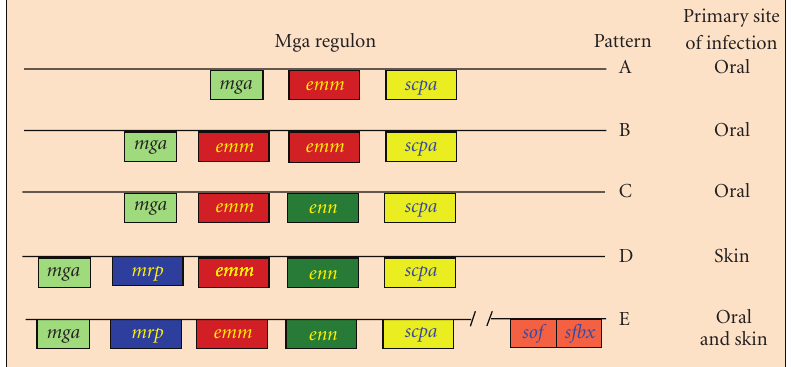
Figure 8: Variants of the Mga regulon and their relationship to preferential colonization of host sites. Mga (multigene activator) is a positive regulator of a number of streptococcal genes. The most prominent of these are the family of M proteins whose genes are tandemly linked. sof and sfbx are bicistronic and are also regulated by Mga, but are located some distance away. emm encodes for M protein, mrp encodes M-related proteins, enn encodes an M-like protein that binds IgA, and scpa encodes a C5a peptidase. Some serotypes contain only mga , emm , and scpa (pattern A). Other serotypes contain one or more of the remaining genes (patterns B–E). S. pyogenes with Mga patterns A, B, and C primarily infect oral tissues, whereas strains with pattern D are predominantly found in tissues of the skin. S. pyogenes with a pattern E Mga regulon are found at both oral and skin sites. Figure derived from data and classification scheme of Bessen and co-workers [47, 48].